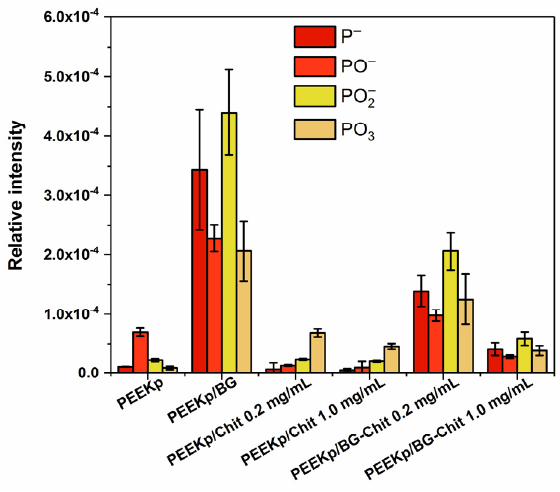
Figure 5. Lateral distribution of phosphorus P − and phosphate PO − ions for PEEKp/BG-Chit 0.2 and 1.0 mg/mL mixed coatings.